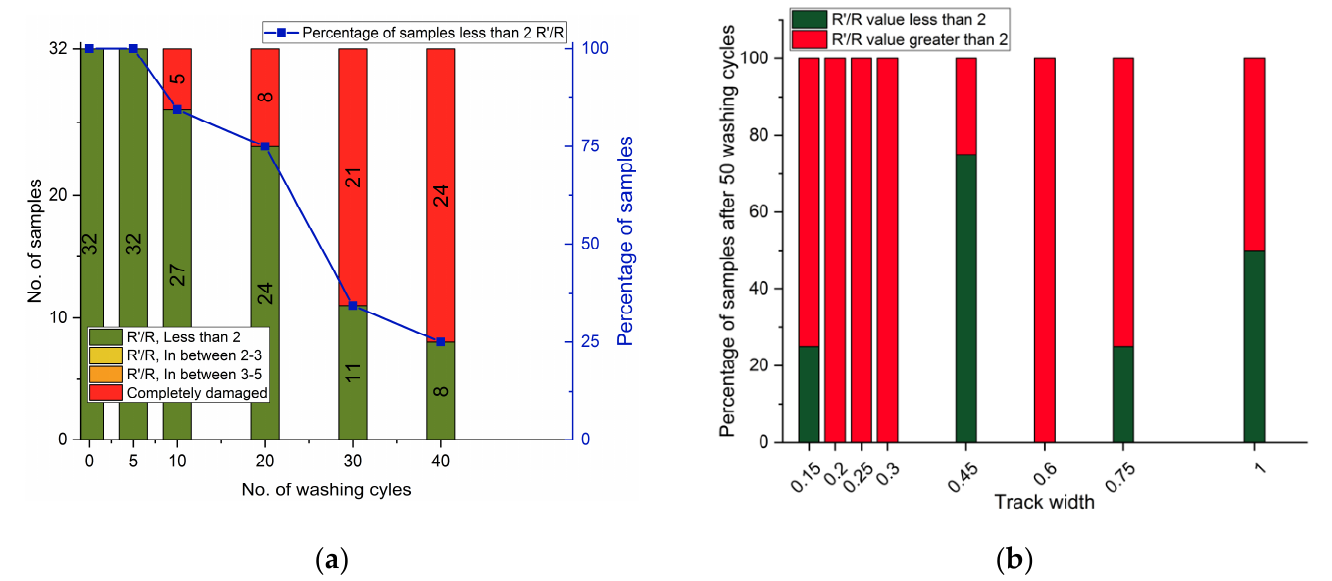
Figure 4. FPCB sample (without any protection) analyses after 40 Express washing cycles, a total of 32 samples were tested: ( a ) No. of samples with R’/R values increased above 2, 3, and ultimately damaged pieces on the left y-axis and percentage of samples having R’/R value below 2 on the right y-axis; ( b ) ratio of samples having R’/R values below and above 2 after complete washing cycles based on track widths.